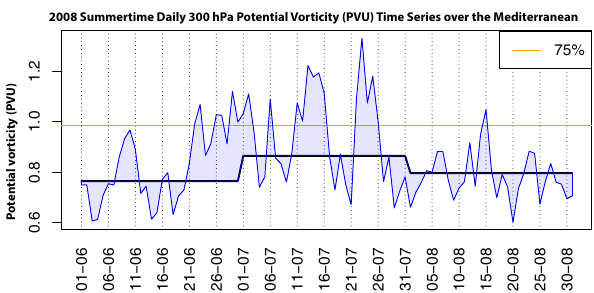
Figure 10. Same as Fig. 9 for the 2008 summertime daily mean of 300hPa potential vorticity (PVU) time series over the Mediter- ranean (12h ERA-Interim reanalysis).